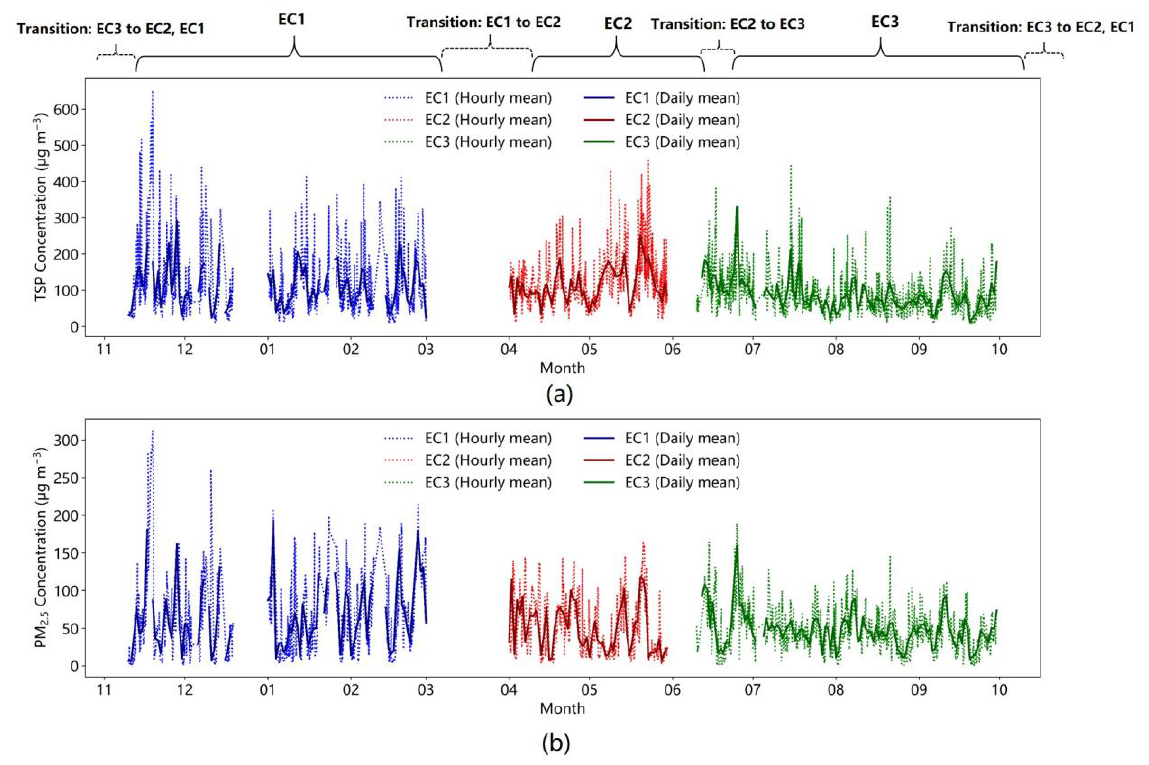
Figure 3. The dynamic variation of hourly and daily mean TSP ( a ) and PM 2.5 ( b ) concentrations in three ECs of the naturally ventilated dairy. Table 2. Hourly mean (±SD) of TSP and PM 2.5 concentrations, indoor T, and indoor RH under three ECs of the dairy barn over a year.